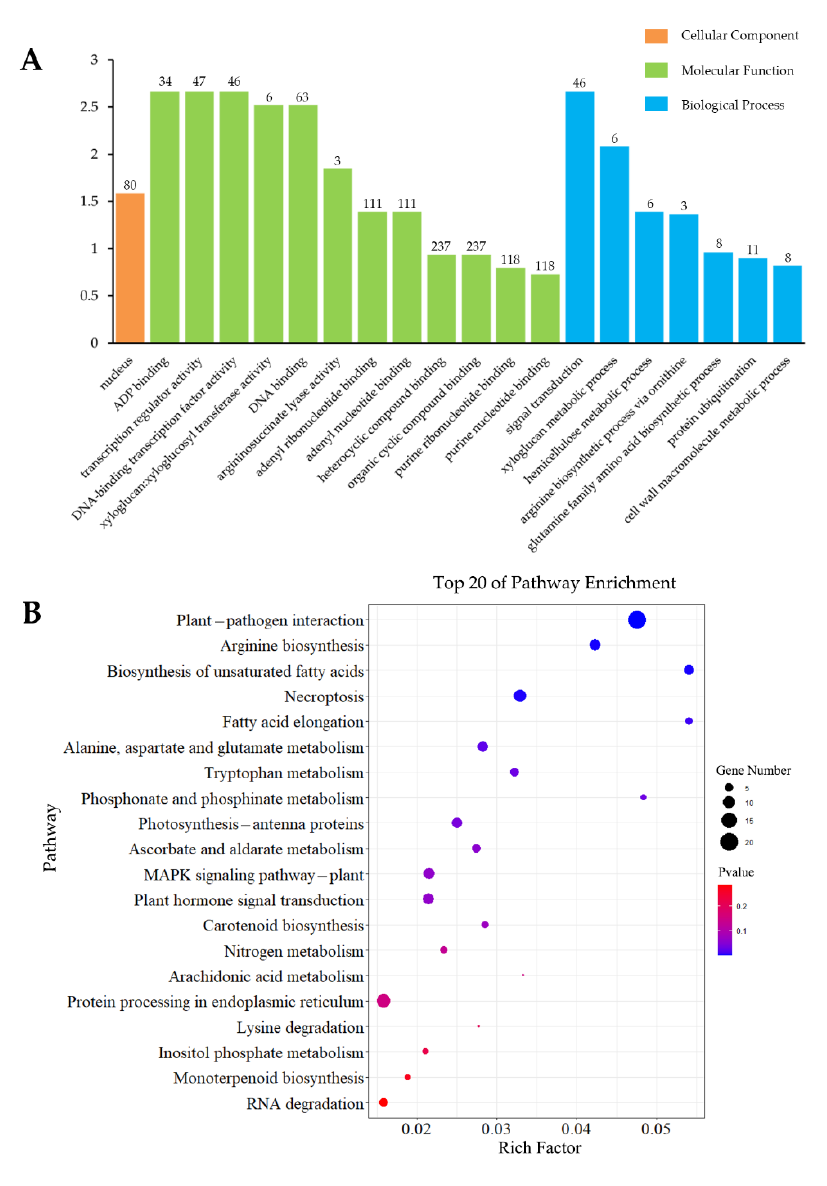
Figure 4. GO ( A ) and KEGG ( B ) analyses of DEGs induced by inoculation specificity.